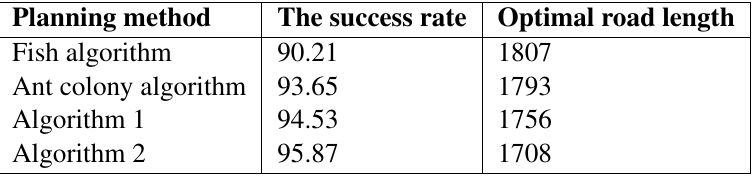
Table 1 Comparison of ship route planning performance of different